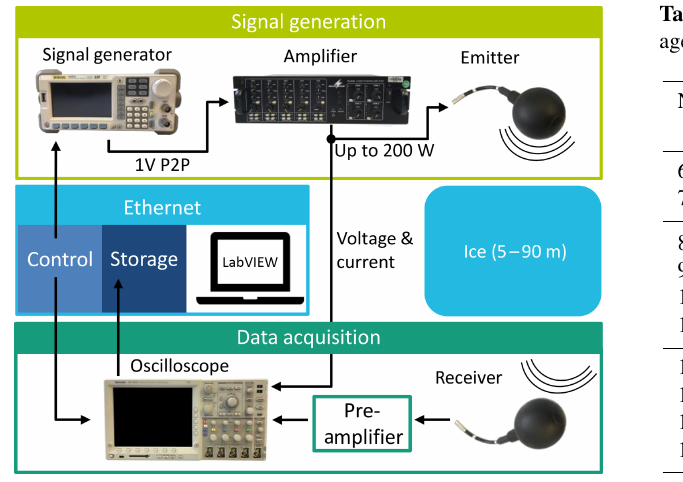
Figure 3. Schematics of the instrument setup.